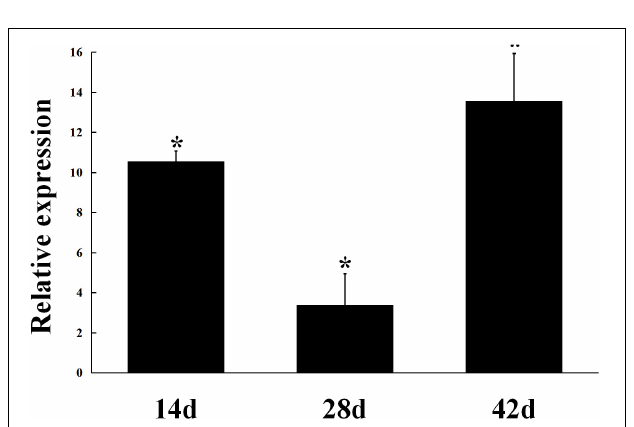
FIGURE 3 | Expression patterns of gmcA gene in symbiotic nodules. Gene expression levels were examined by real-time RT-PCR. Nodules were collected on different days after inoculation with RL3841. Relative expression of gmcA gene in symbiotic nodule bacteroids compared with RL3841 wild type cells growth in AMS Glc/NH 4 + medium. Data are the average of three independent biological samples (each with three technical replicates). Superscript asterisk indicates significant difference in relative expression ( > 2-fold, P ≤ 0.05).